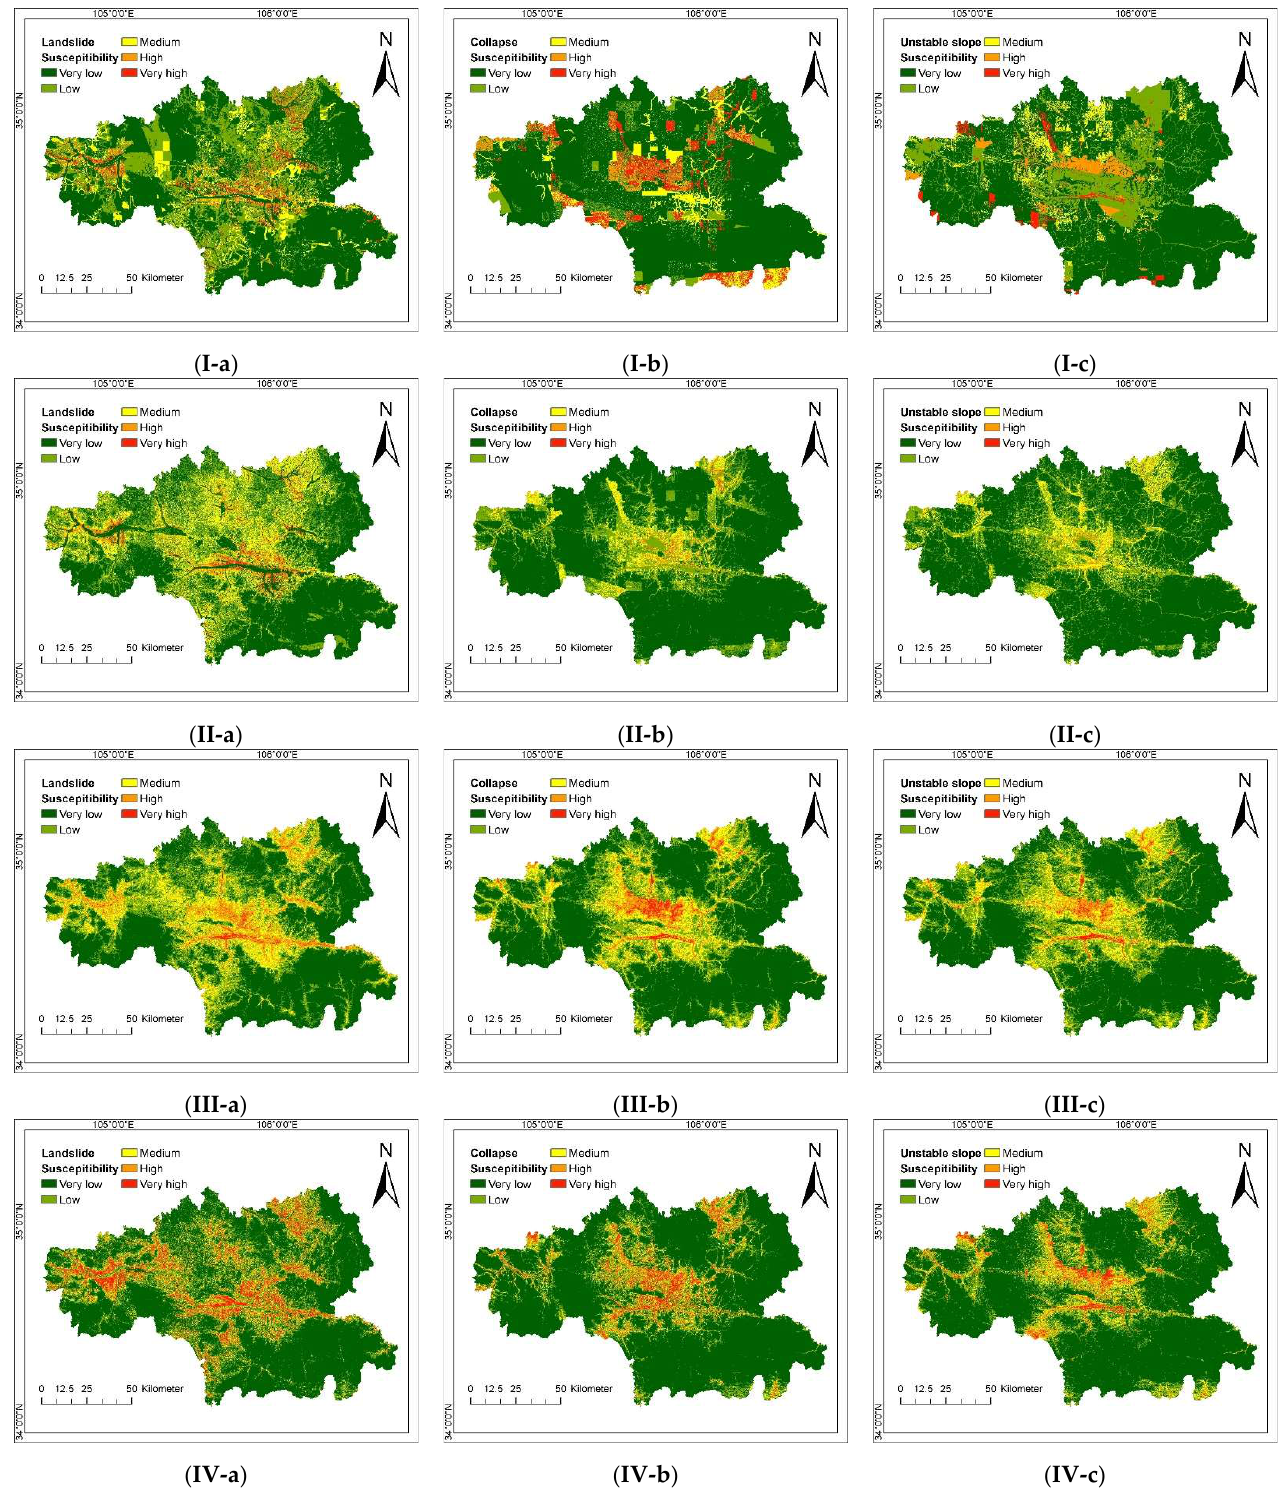
Figure 11. LSM results in Tianshui city. Line I : results of CART; I-a : Landslide; I-b : Collapse; I-c : Unstable slope; Line II : results of RF; II-a : Landslide; II-b: Collapse; II-c : Unstable slope; Line III : results of LR; III-a : Landslide; III-b : Collapse; III-c : Unstable slope; Line IV : results of SVC; IV-a : Landslide; IV-b : Collapse; IV-c: Unstable slope.